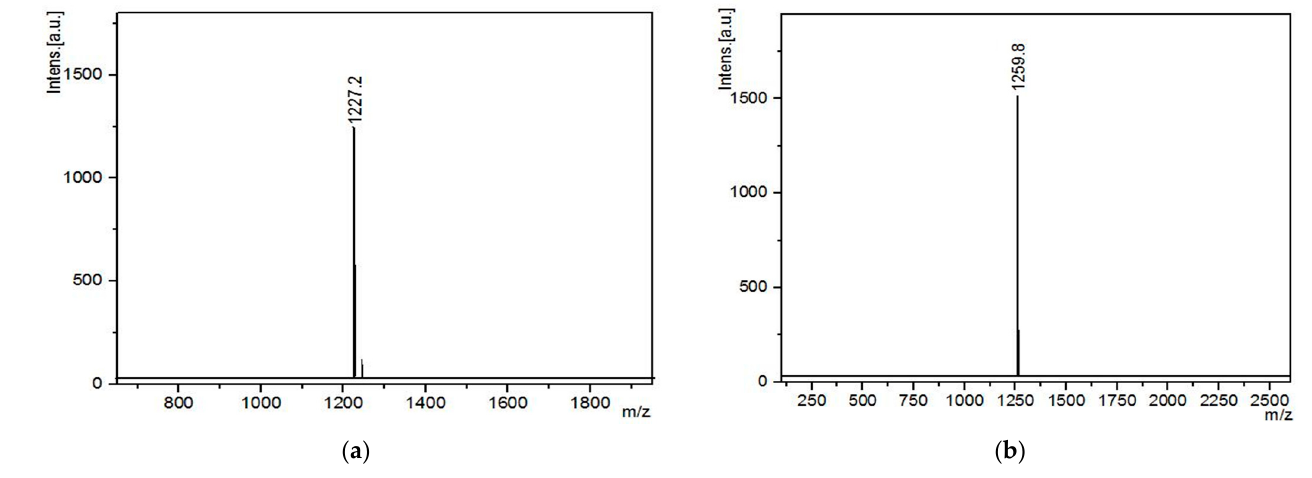
Figure 6. MALDI-TOF mass spectra of ( a ) DDSQ-VS and ( b ) DDSQ-EP.